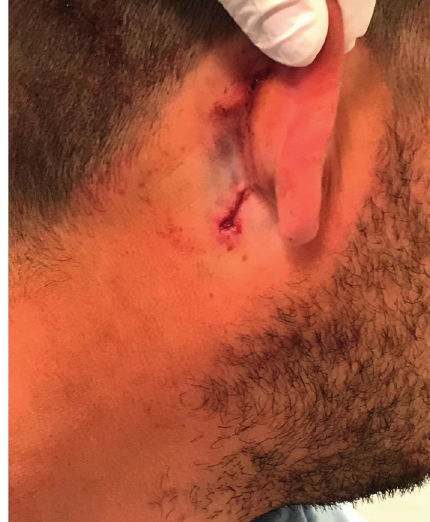
Figure 1: Retroauricular injury upon admission of the patient.